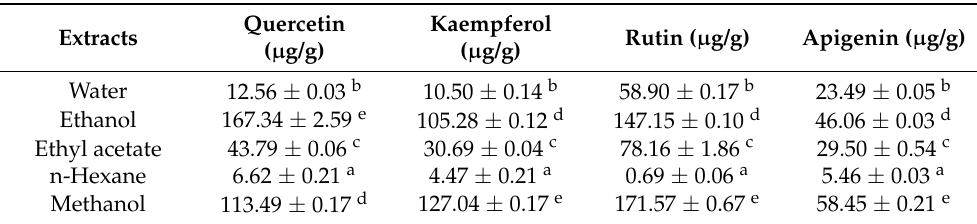
Table 3. HPLC analysis of some common flavonoids constituents in A. hendersonii leaf extracts obtained using various